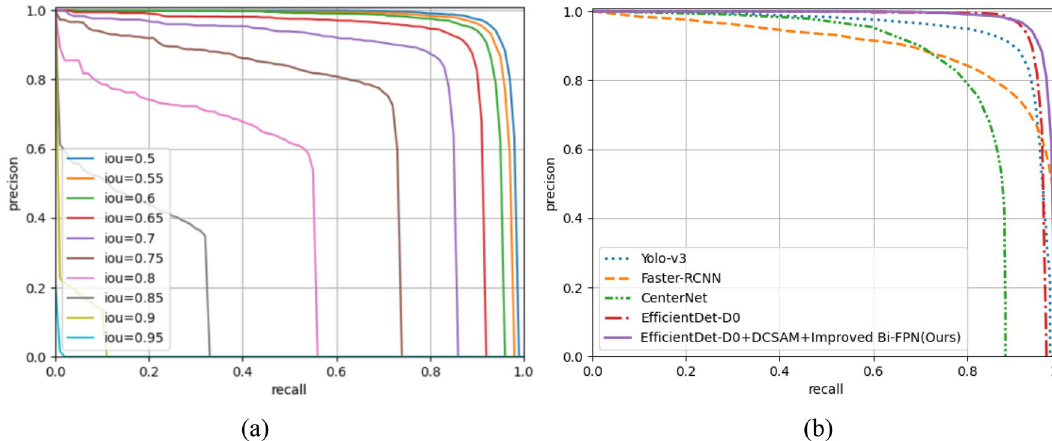
Figure 16. P-R curve comparison diagram, ( a ) P-R curve of this algorithm under different IOU thresholds, ( b ) P-R curve of different detection algorithms when IOU = 0.5.